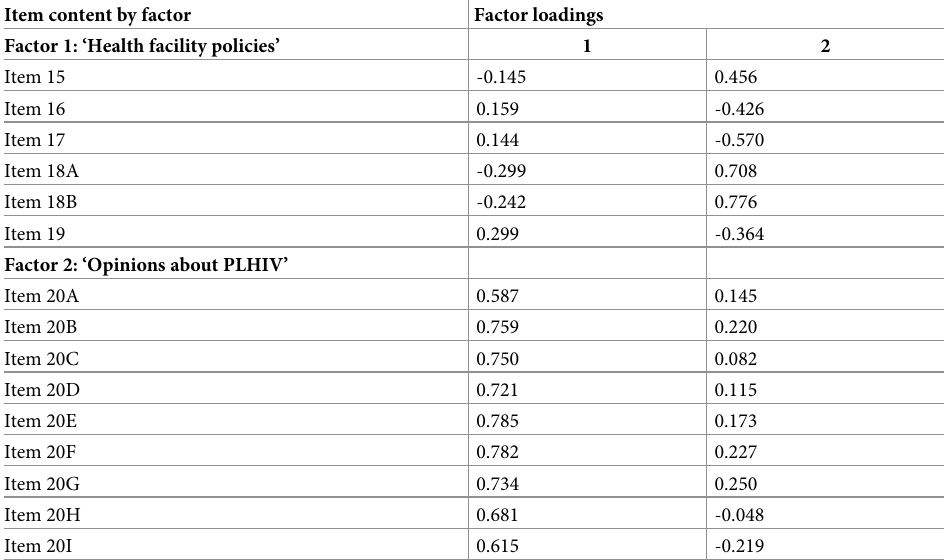
Table 3. Factor loadings of the original and extended HIV-related sigma scales on EFA models (N = 196). Item content by factor